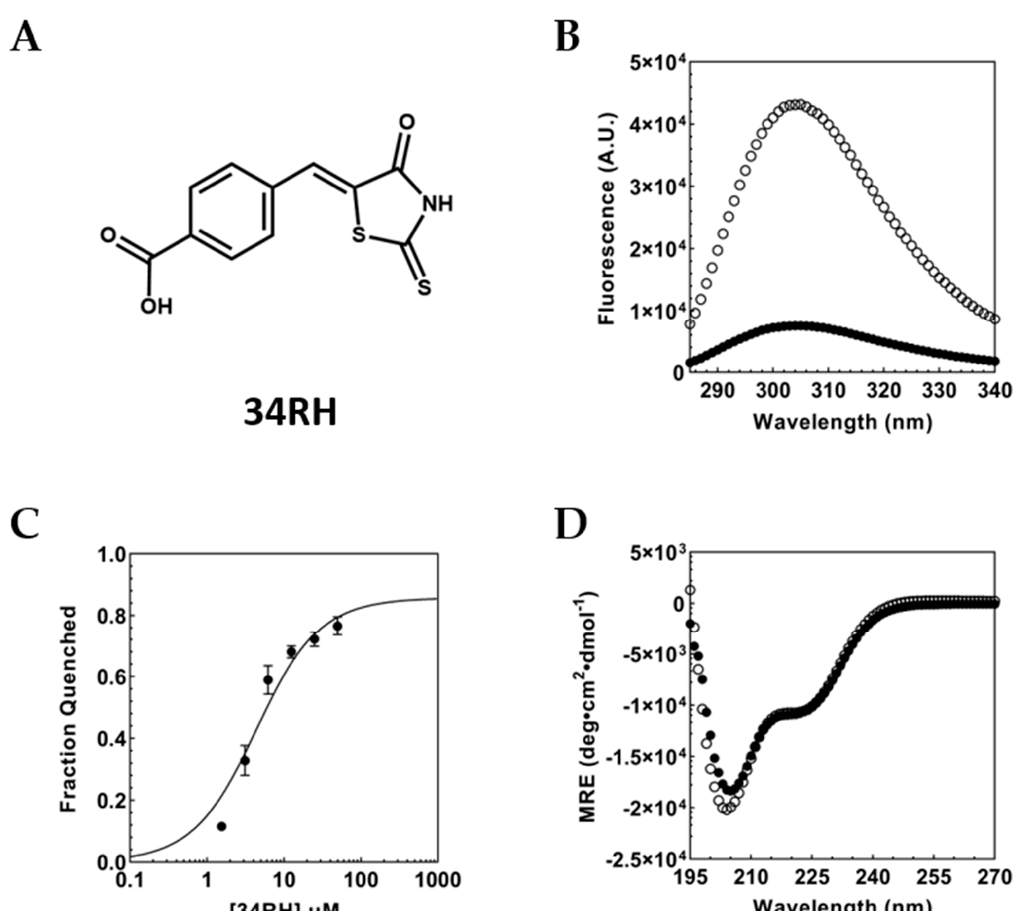
Figure 1. ( A ) Structure of 34RH. ( B ) Inner filter corrected fluorescence emission spectrum of 1 µ M Myc 353–437 with (black circles) and without (white circles) 50 µ M 34RH in 1xPBS at 25 ◦ C, pH 7.4. ( C ) Equilibrium titration of 1 µ M Myc 353–437 with excess 34RH fit to a Langmuir binding isotherm, K D = 3.9 ± 1.3 µ M. Error bars represent the standard error of three independent trials. ( D ) Circular dichroism of 2.5 µ M Myc 353–437 with (black circles) and without (white circles) 50 µ M 34RH in 1xCD buffer.